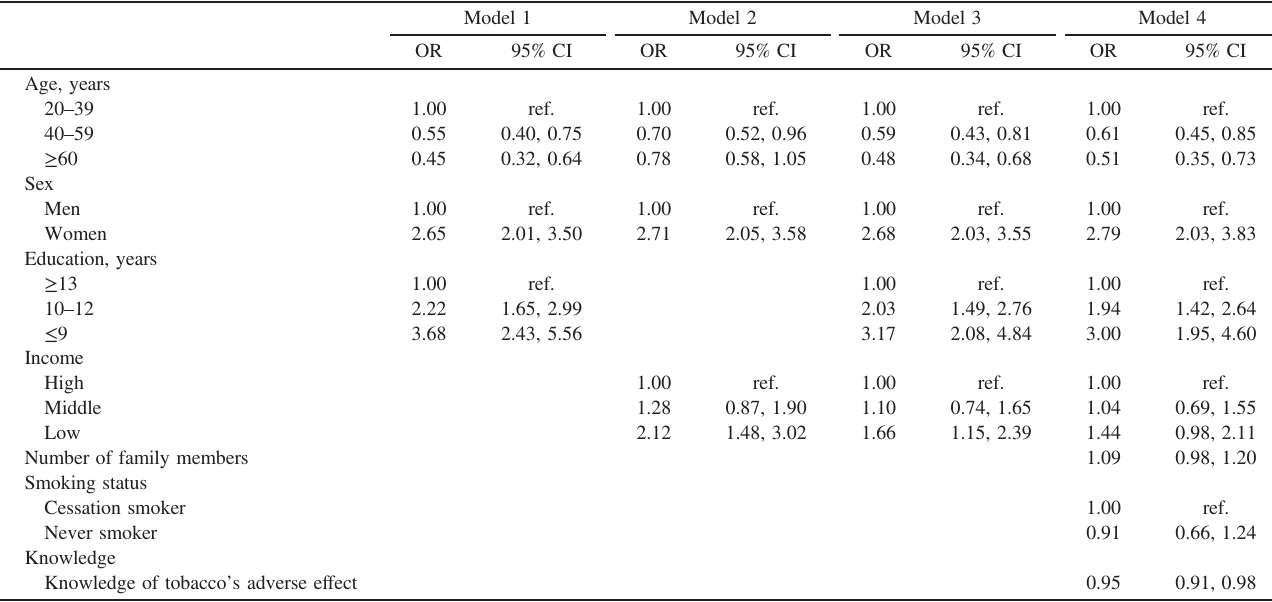
Table 3. Odds ratios for secondhand smoke at home ( n = 1,738); multiple imputation was